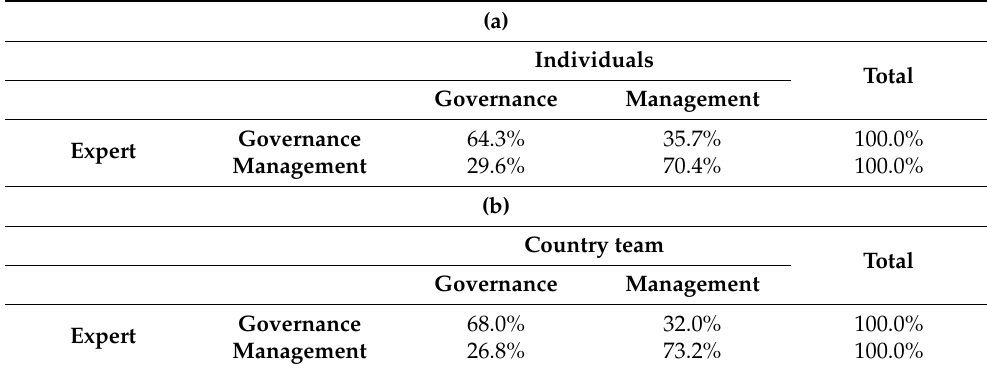
Table 2. Confusion matrices with (a) individuals’ and (b) country teams’ agreement with expert in Group 2.